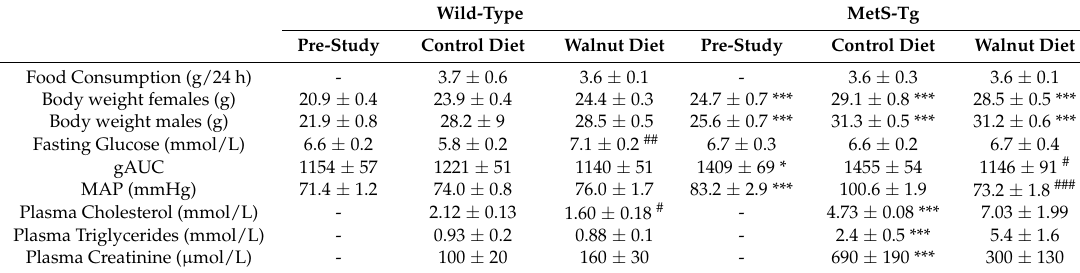
Table 2. Physiological and blood biochemistry data pre- and post-study diets (means ± SEM). Wild-Type MetS-Tg Pre-Study Control Diet Walnut Diet Pre-Study Control Diet Walnut Diet